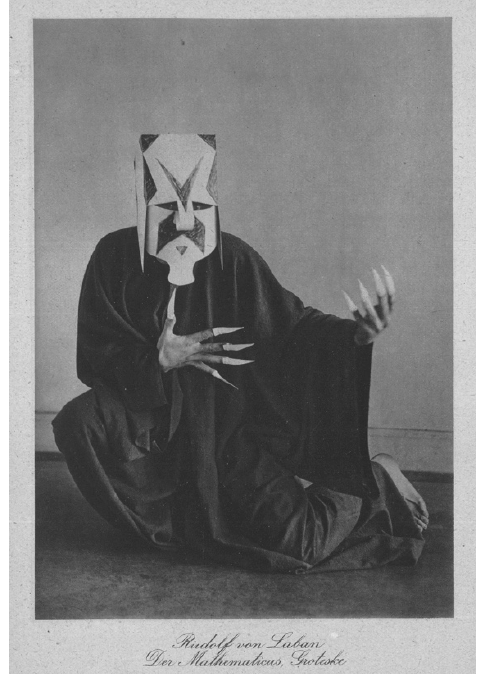
Figure 2. Photograph of Rudolf von Laban as Mathematicus, ca. 1915–1918. In Rudolf von Laban, Die